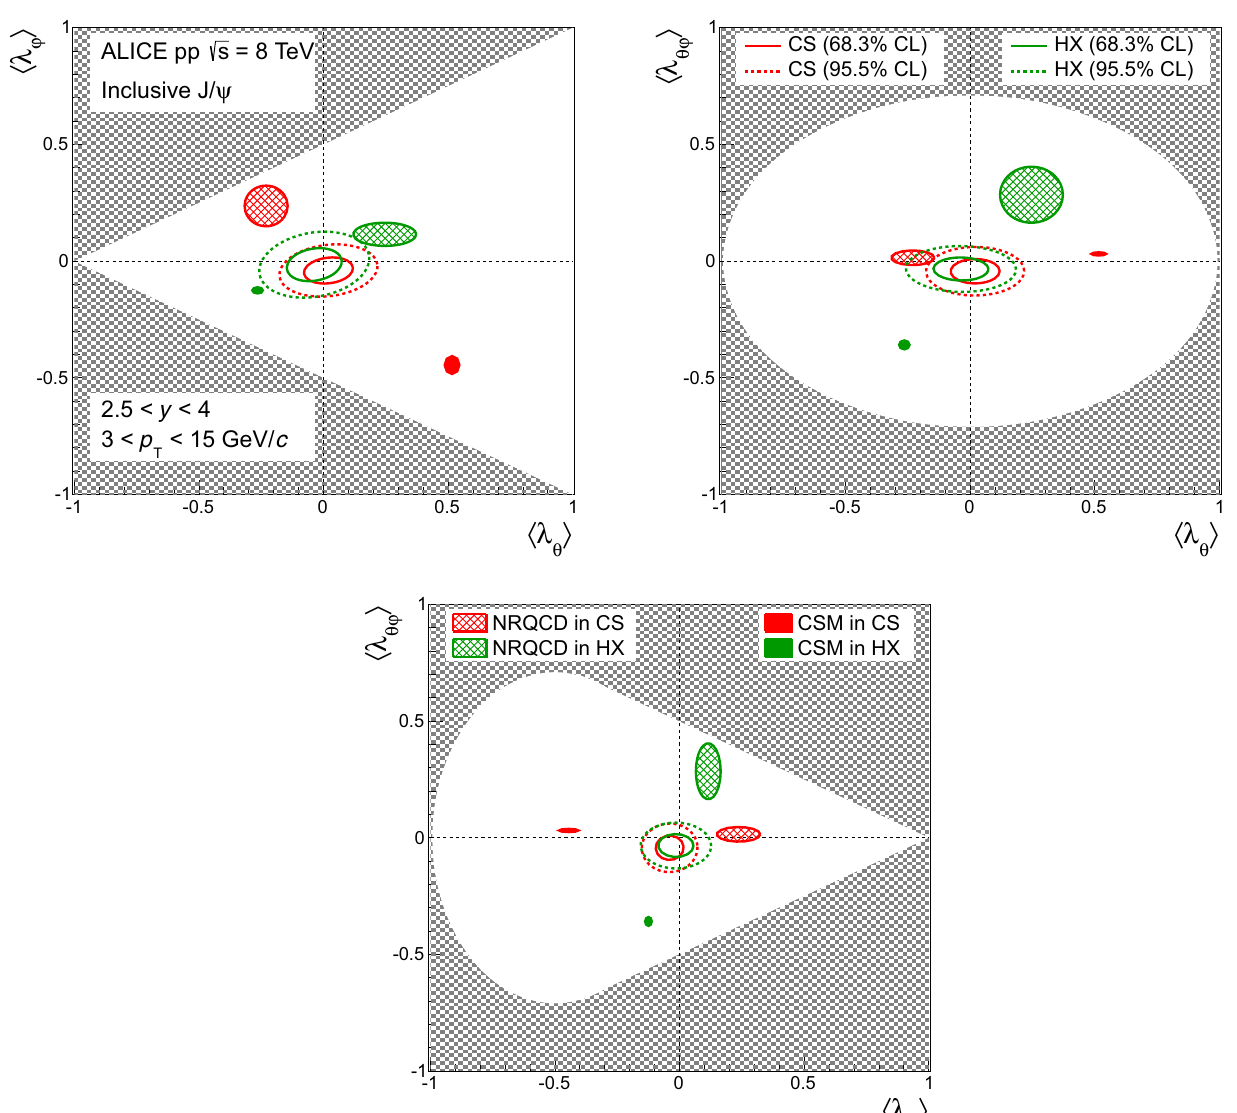
Fig. 6 Average p T -integrated (in rapidity range 2 . 5 < y < 4 . 0) inclu- sive J/ ψ polarization parameters (cid:7) λ θ (cid:8) , (cid:7) λ ϕ (cid:8) and (cid:7) λ θϕ (cid:8) in allowed 2-D regions (white areas) for 3 < p T < 15 GeV / c . Full (dashed) ellipses show 1- σ (2- σ ) contours in Collins-Sopper (CS, red) and helicity (HX,